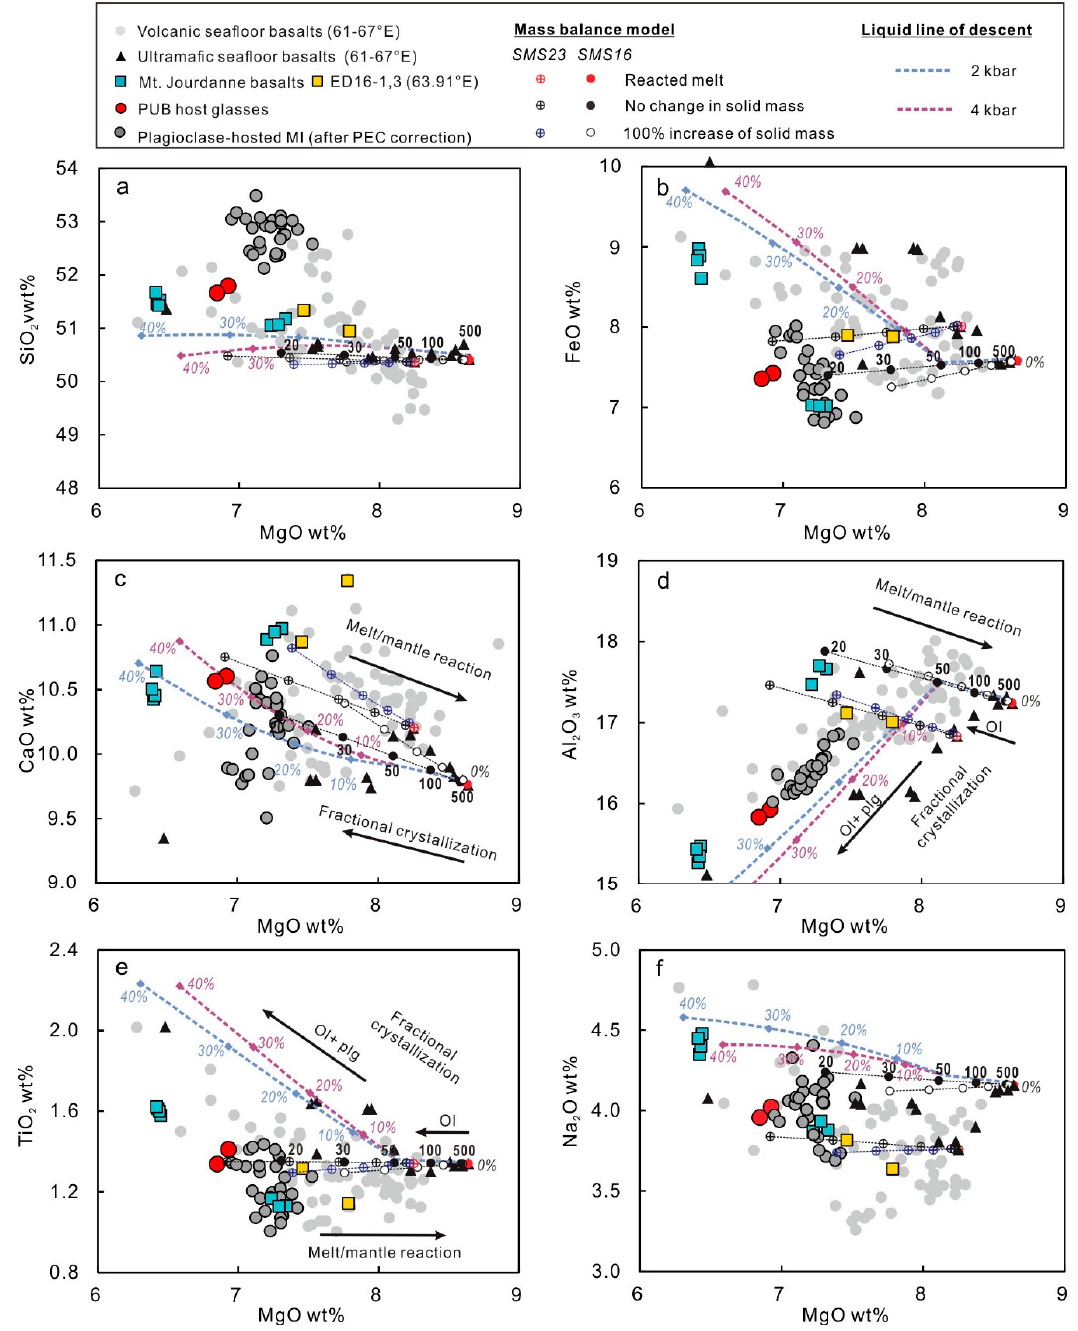
Figure 9. Liquid lines of descent (LLD) in the plot of ( a ) SiO 2 , ( b ) FeO, ( c ) CaO, ( d ) Al 2 O 3 , ( e ) TiO 2 and ( f ) Na 2 O contents as a function of MgO content. LLDs calculated using the Petrolog 3 software [51] with an ultramafic seafloor basalt SMS16-3-5 (from Paquet et al. [30]) as the starting composition. Diamond dots along these trends correspond to percent of crystallization. The mass balance model modified from Paquet et al. [30] is plotted in this figure, showing the possible effect of melt/rock interactions on the major element compositions of basalts in the SWIR (61–67° E). Dotted lines show the melt/rock reaction trend, with values from 20 to 500 corresponding to the ratio of the final mass of melt (i.e., the mass that could be erupted) over the initial mass of solid (i.e., the initial mass of reacted mantle). At high melt/rock ratios, reactions have little effect on the melt composition, whereas at low melt/rock ratios, the calculated initial composition of the melt has lower MgO and FeO contents, but higher CaO and Al 2 O 3 contents, similar to some Mount Jourdanne basalts. Data source and symbols as in Figure